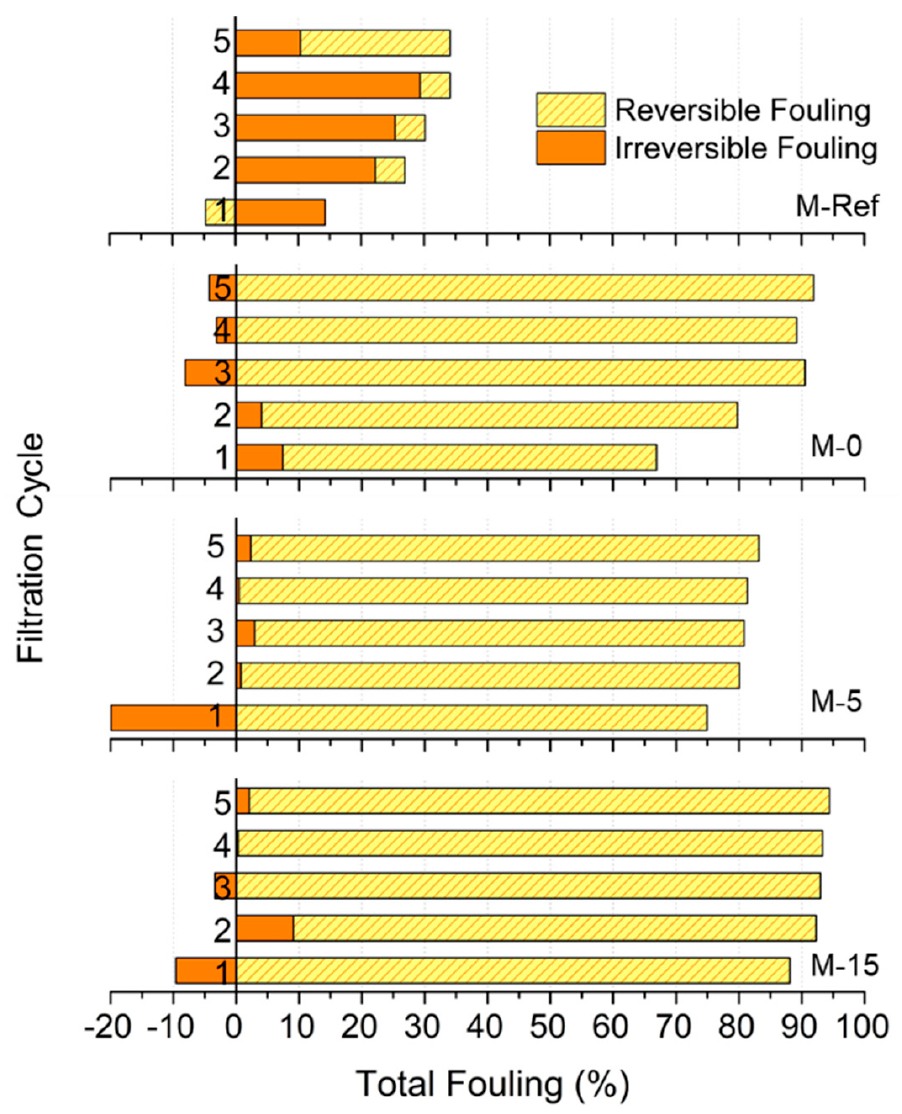
Figure 11. Fouling resistance analysis of the modified membranes.